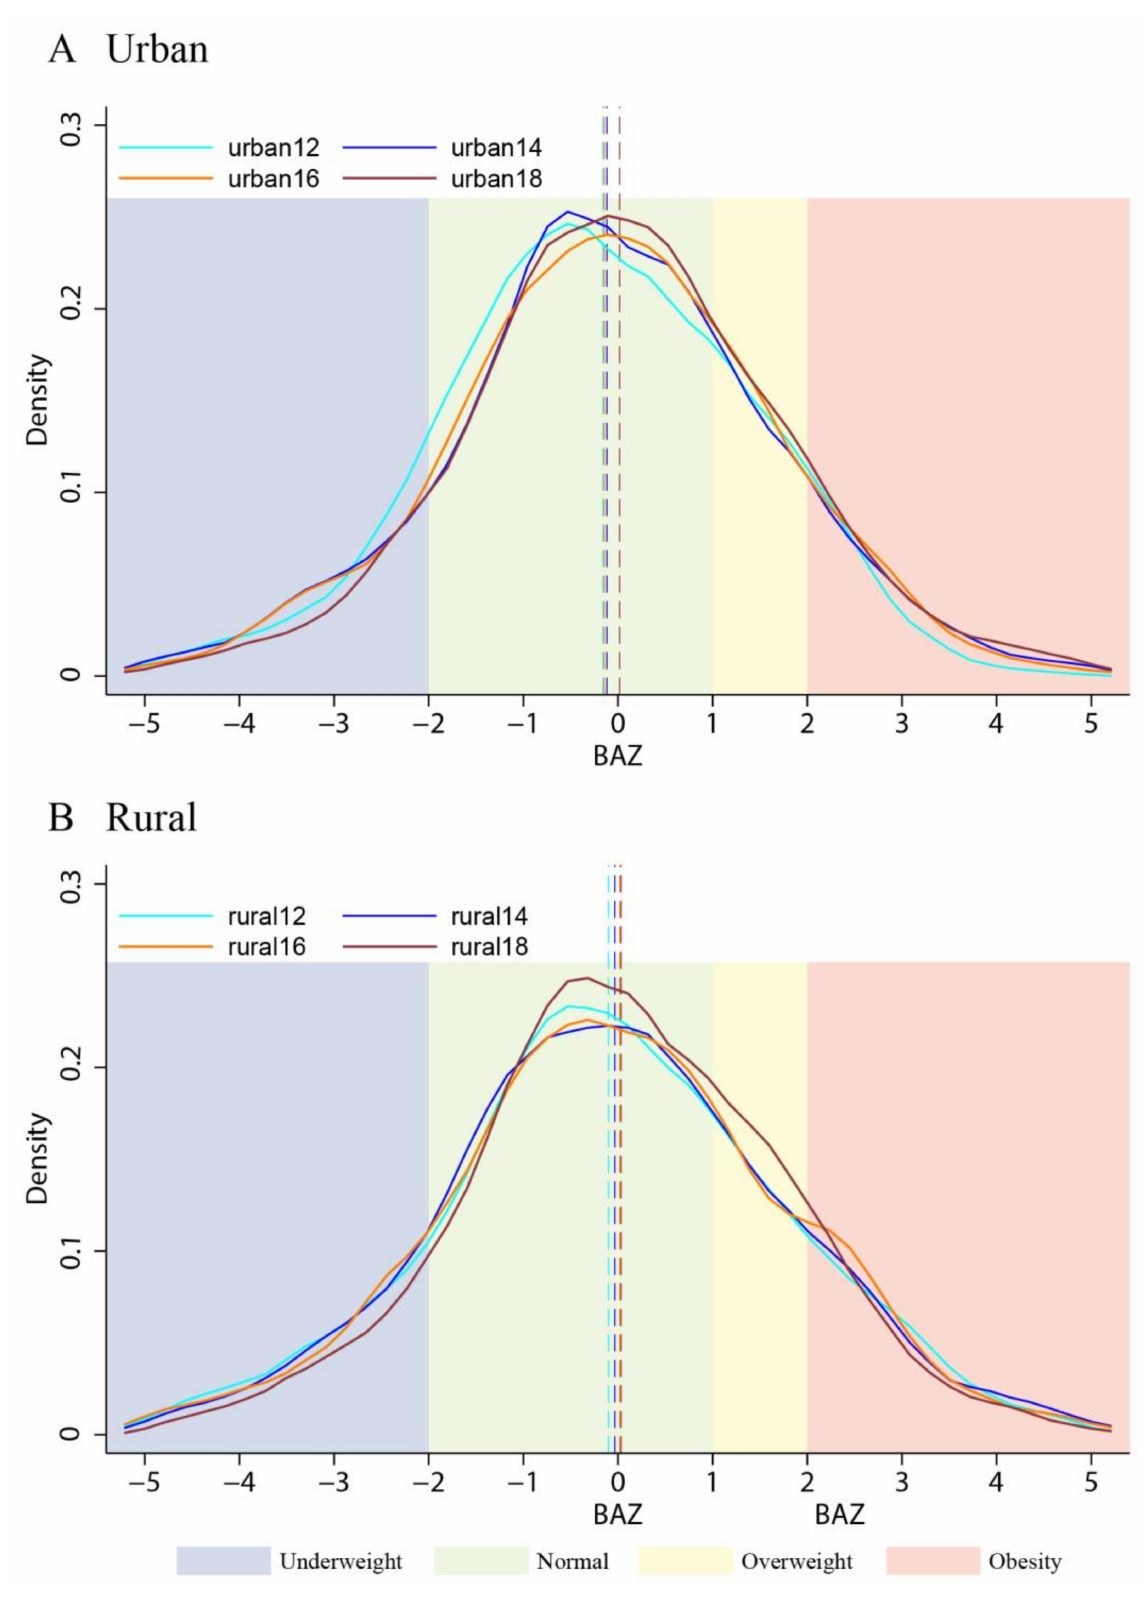
Figure 2. Distributions of BAZ among urban children ( A ) and rural children ( B ) from 2012 to 2018. Note: 1. Curves were plotted with the CFPS cross-sectional data. Epanechnikov kernel density estimates were used with cross-sectional weights adjusted according to the national census (2010, 2020). 2. Dashed vertical lines represent mean